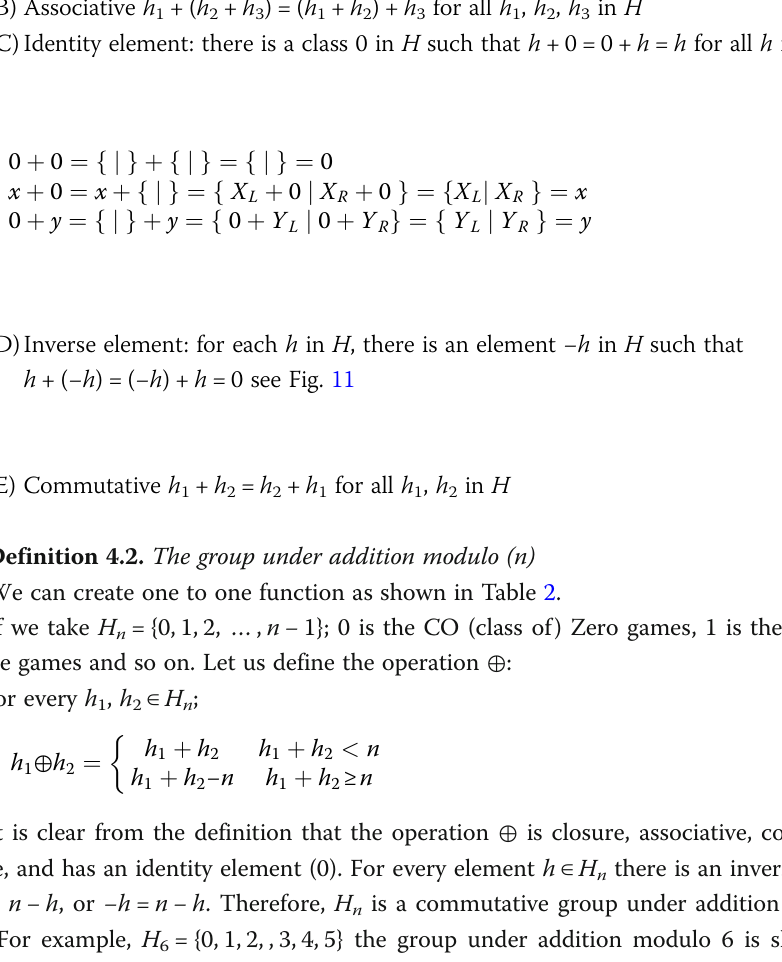
The inverse of the element 1 is − 1 = 6 − 1 = 5 and the inverse of 2 is − 2 = 6 − 2 =